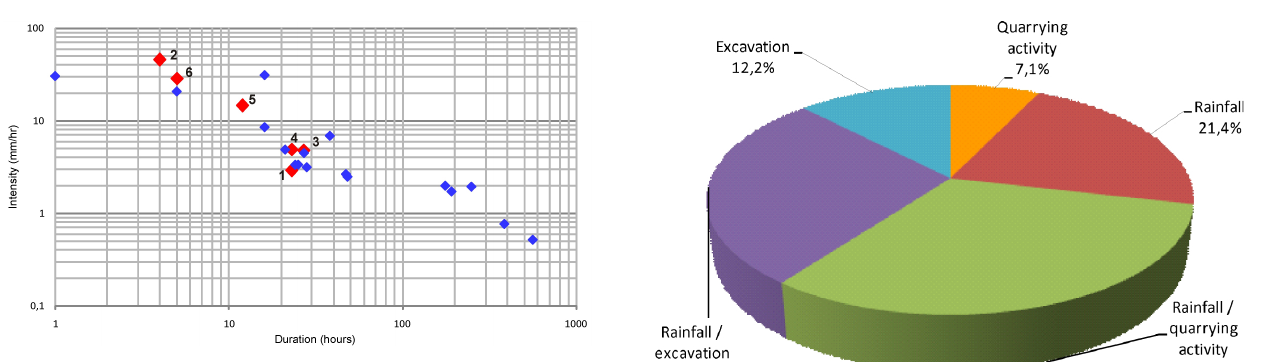
Fig. 5. Annual distribution of the Naples’ landslides for the period 1868–2011.